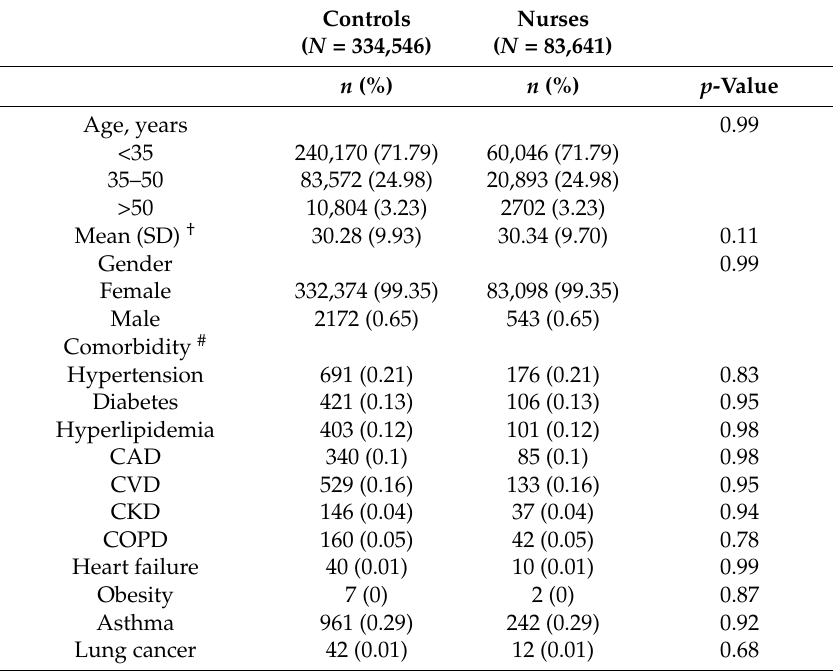
Table 1. Demographics and comorbidity in nurse and control